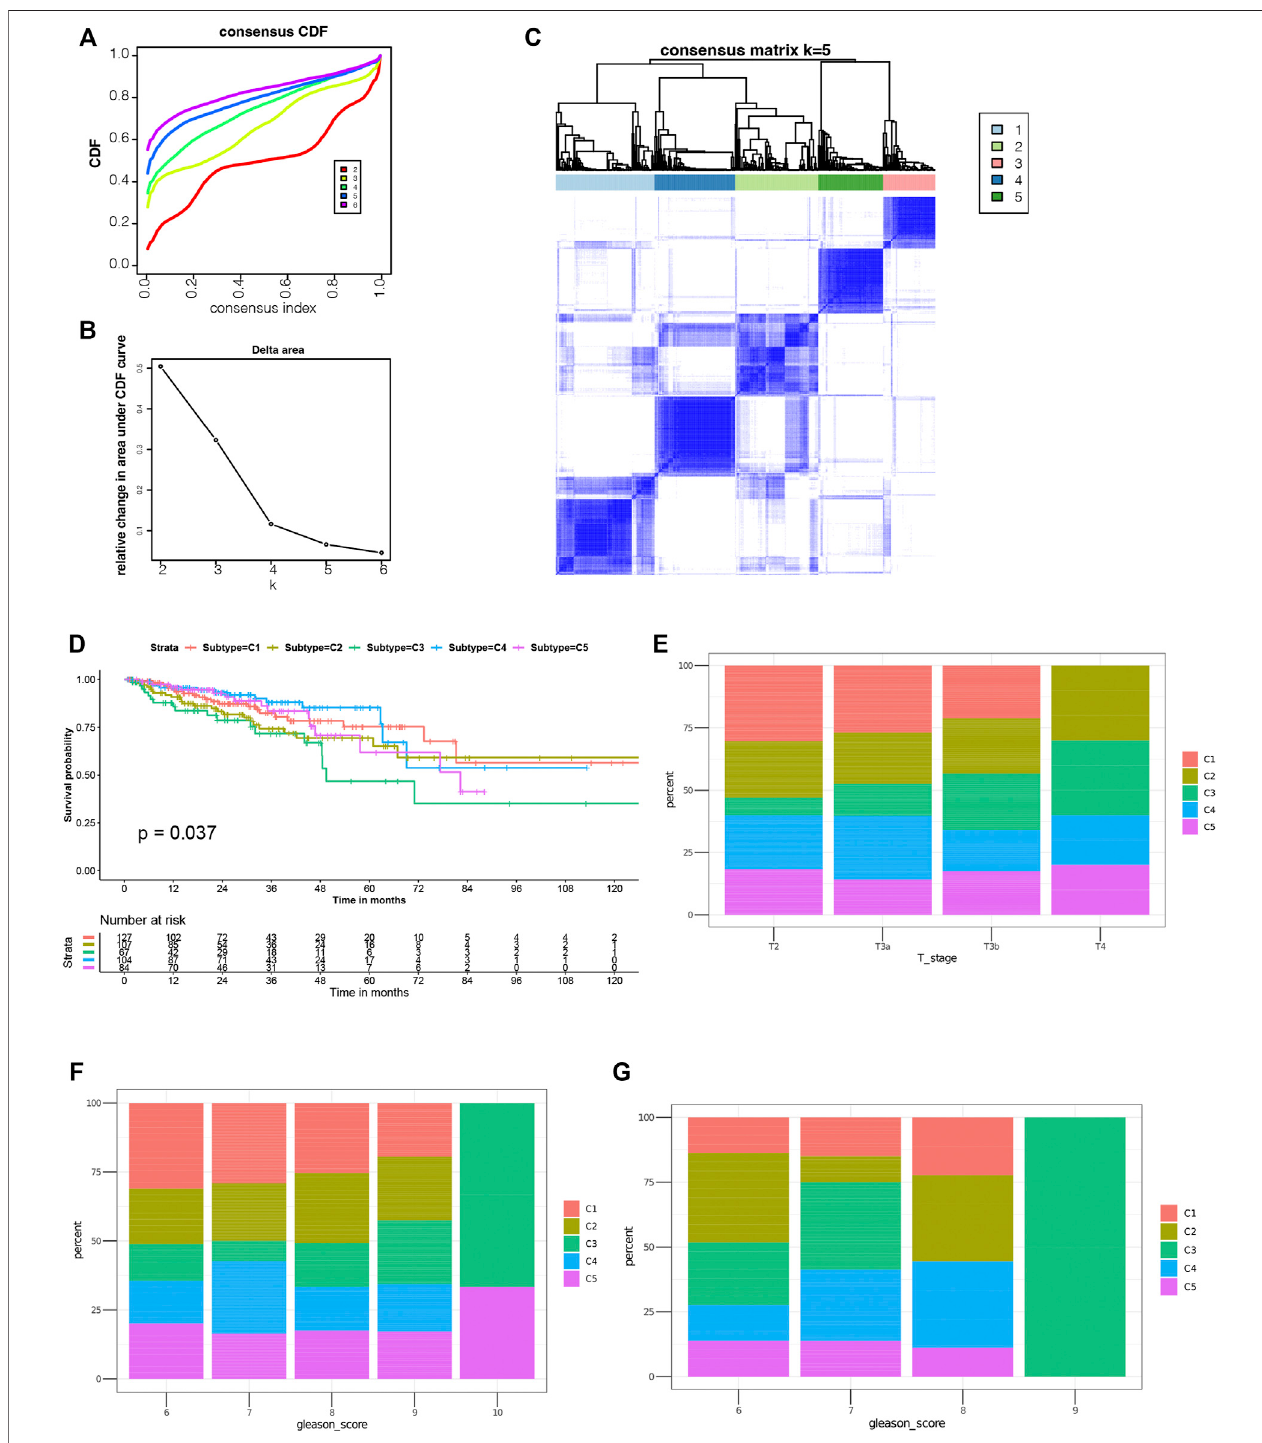
FIGURE 4 | Identi fi cation of potential immune subtypes of PRAD. (A) Cumulative distribution function curve and (B) delta area of immune-related genes in TCGA cohort. (C) Sample clustering heat map. (D) Kaplan-Meier curves showing prognosis of PRAD immune subtypes in TCGA cohort. (E,F) Distribution of C1-C5 across PRAD (E) stages and (F) Gleason score in TCGA cohort. g Distribution ratio of C1-C5 across PRAD Gleason score in ICGC cohort.